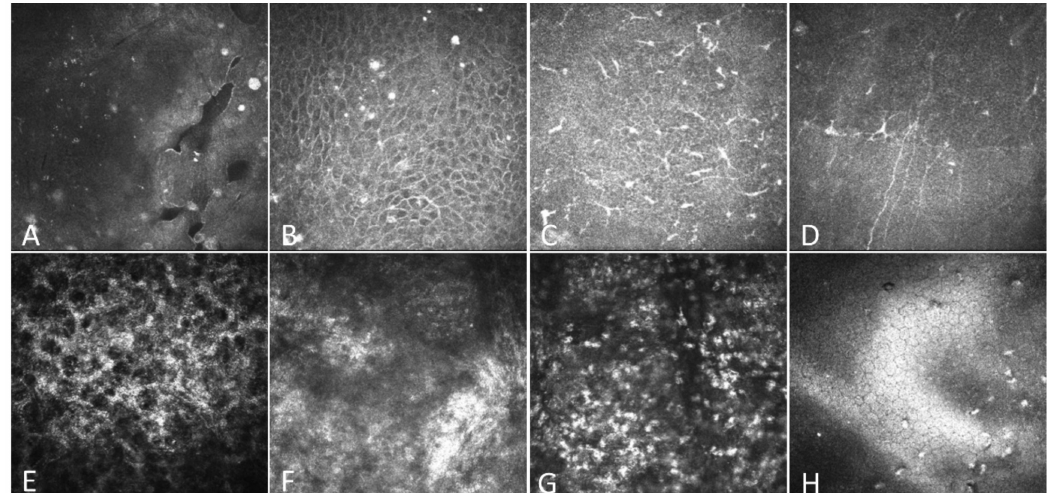
Figure 3. IVCM findings of the cornea in patients with RCEs. All images were obtained using the HRT-3-RCM system with a field of 400 µ m × 400 µ m. ( A ) Microcysts and gaps due to epithelial defects. ( B ) Elongated superficial cells and brightly reflective granular structures. ( C ) Increased activation of Langerhans cells. ( D ) Decreased corneal subbasal nerves. ( E ) Activated keratocytes in the shallow stroma. ( F ) Disorganized stroma fibers. ( G ) Infiltrated cells in the middle stroma. ( H ) Deposit on the